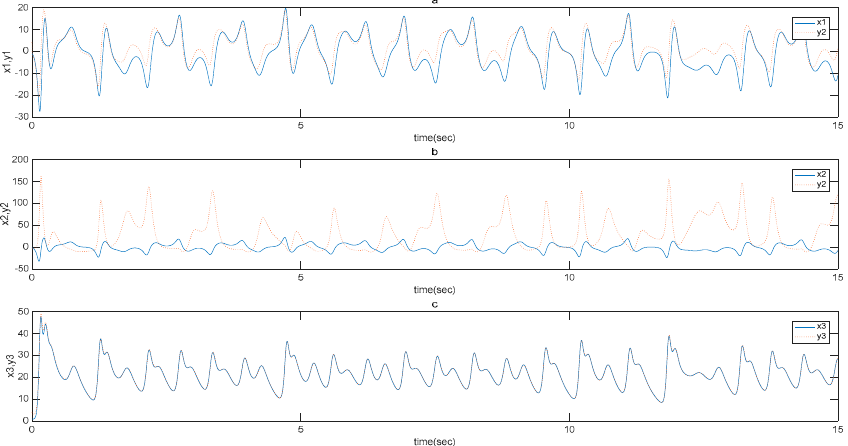
Figure 15. Synchronization effect diagram.